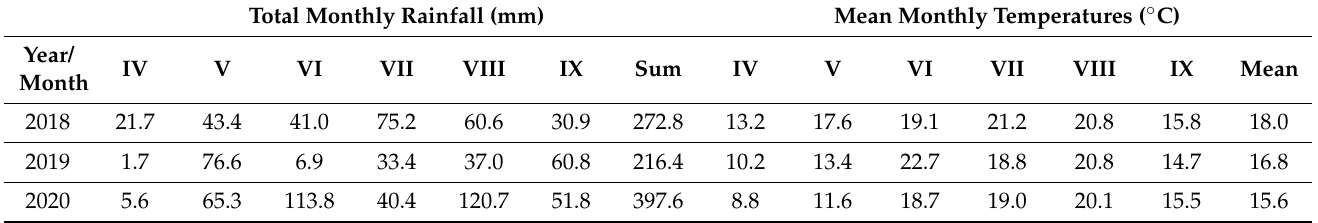
Table 3. Total monthly rainfall and mean monthly temperatures during the vegetative growth period in the years 2018–2020 for Jadwisin. Total Monthly Rainfall (mm)